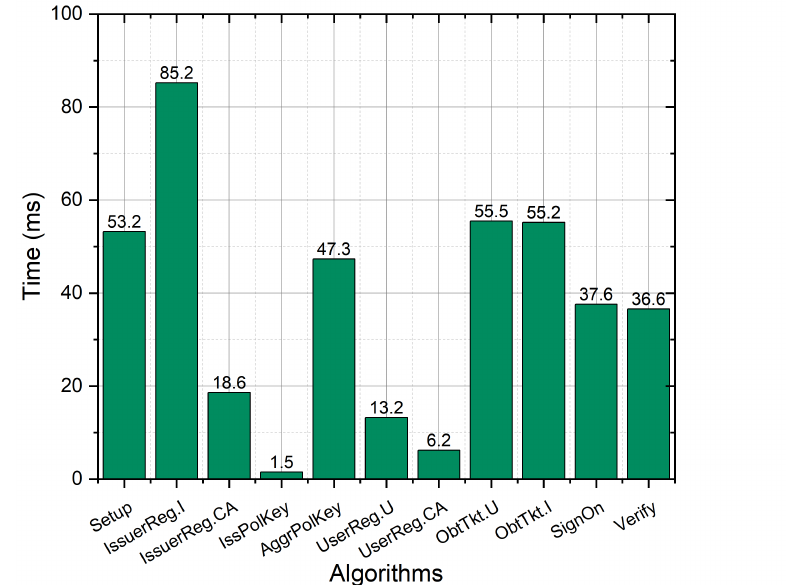
Figure 13. Execution time of algorithms.